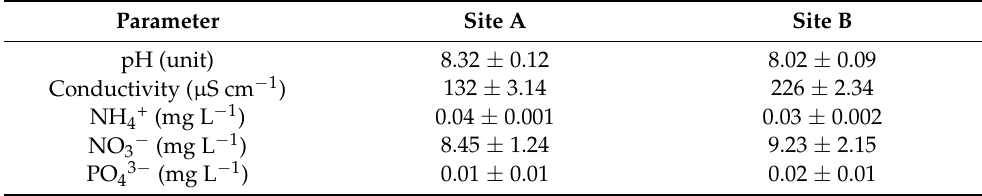
Table 1. Mean and standard deviation (three replicates) of physicochemical parameters and nutrients measured at site A and site B. NO 3– denotes nitrate, NH 4+ ammonia, PO 43– phosphate concentrations (mg L − 1